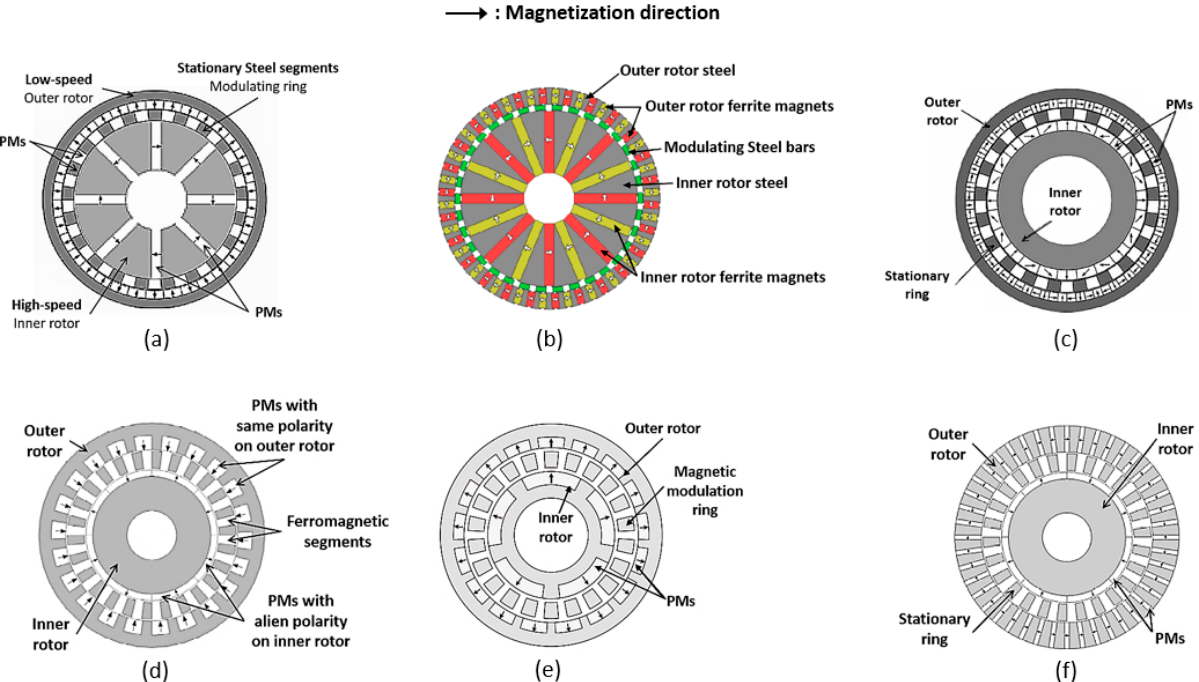
Figure 10. Field-modulated coaxial magnetic gear topologies: ( a ) Spoke-Type Coaxial MG Tangen- tially Magnetized—Inner Rotor; ( b ) Spoke Ferrite MG; ( c ) Surface-Mounted Coaxial MG Halbach Magnetized; ( d ) Coaxial MG Same-Polarity Magnetized—Outer Rotor; ( e ) Coaxial MG Radially Mag- netized, Same-Polarity—Both Rotors; ( f ) Surface-Mounted Coaxial MG Tangentially Magnetized— Outer